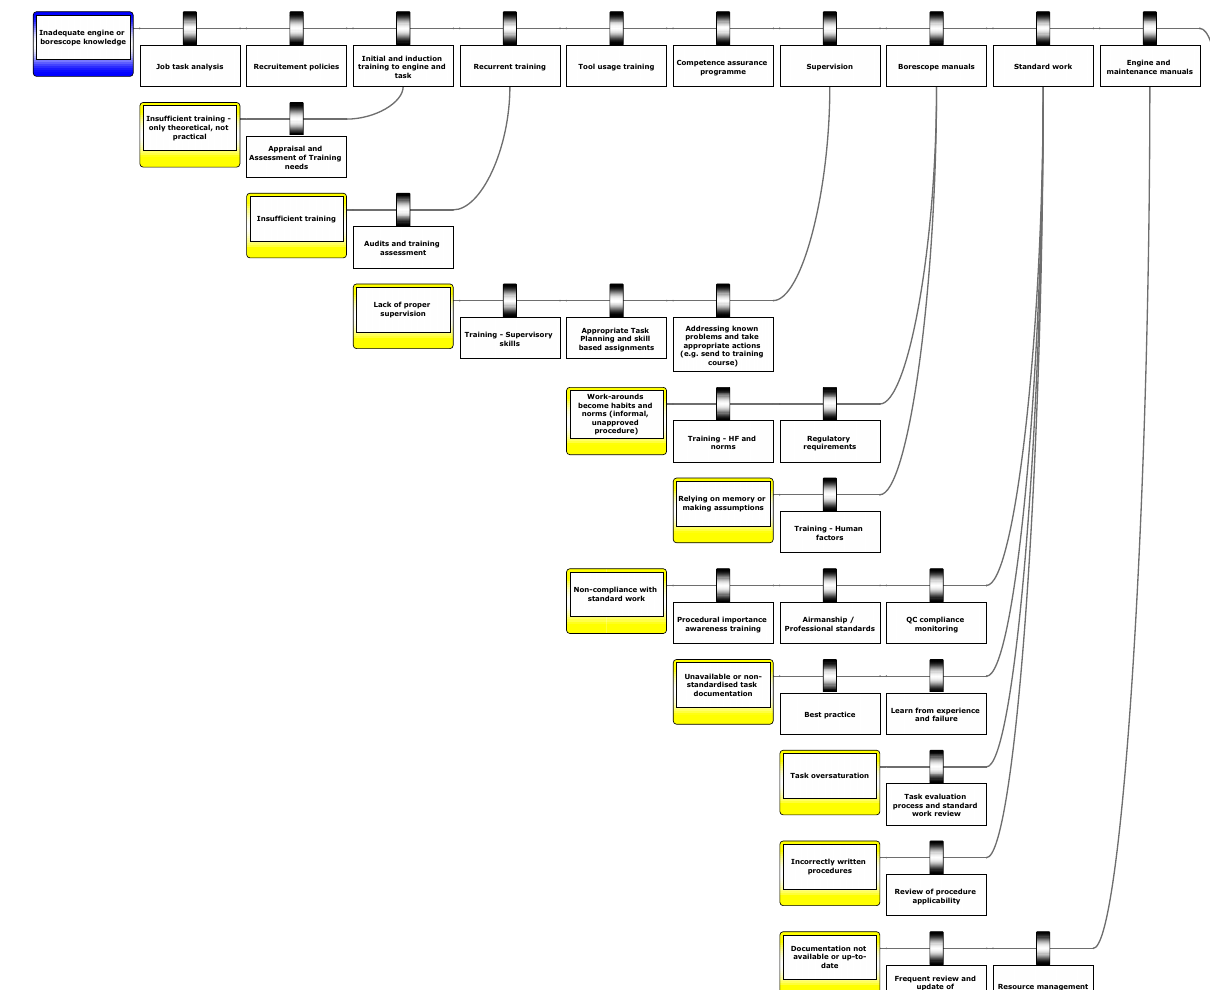
Figure A2d. “Inadequate engine or borescope knowledge” threat